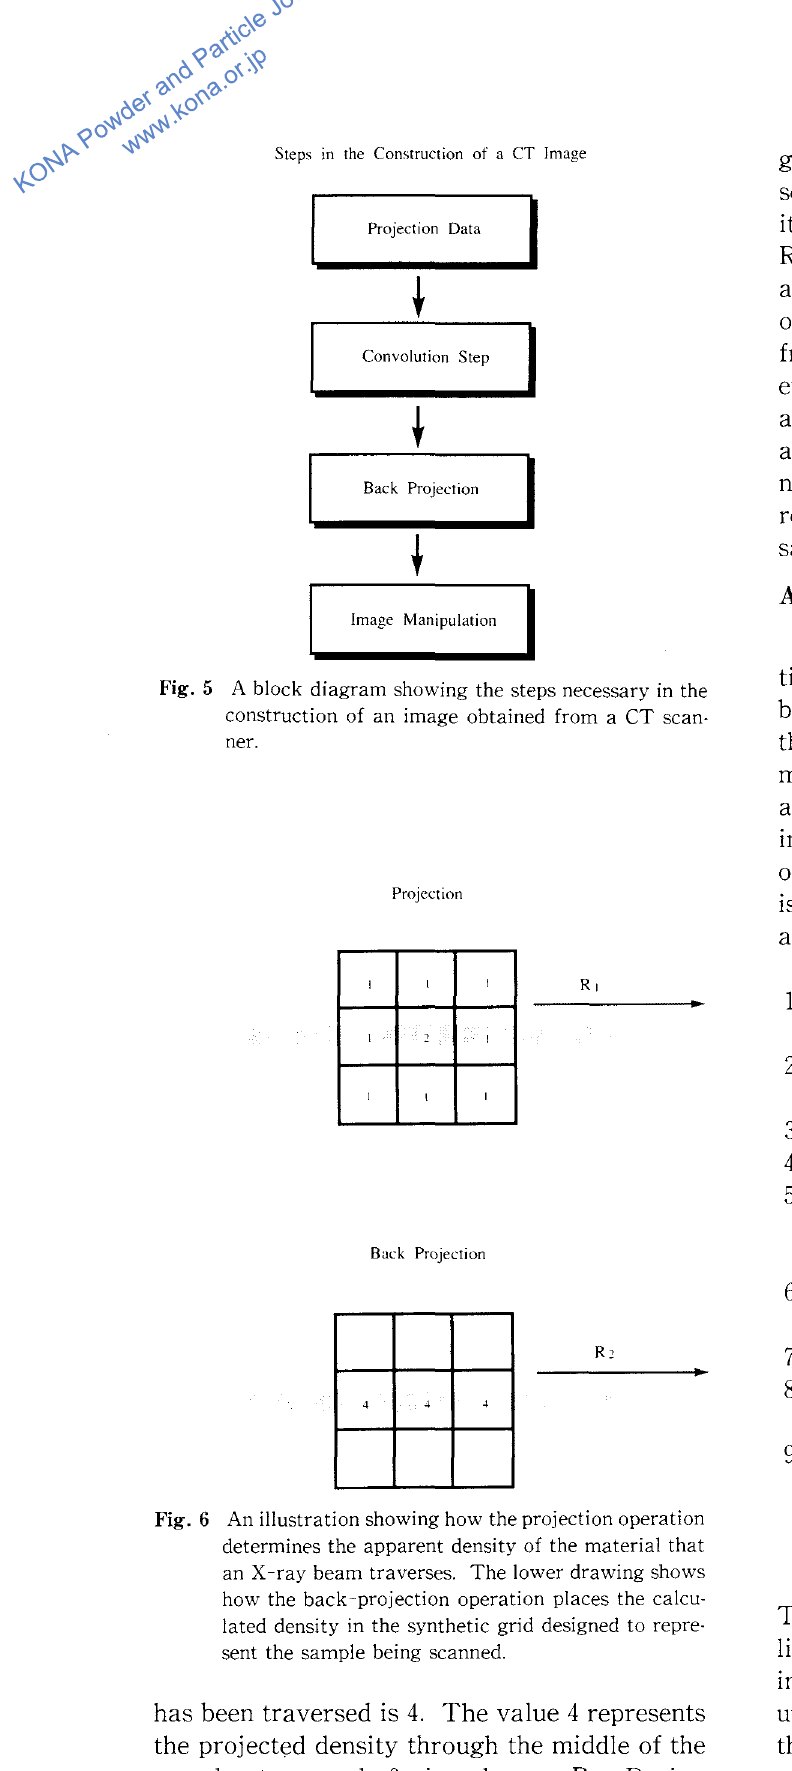
Fig. 6 An illustration showing how the projection operation determines the apparent density of the material that an X -ray beam traverses. The lower drawing shows how the back-projection operation places the calcu lated density in the synthetic grid designed to repre sent the sample being